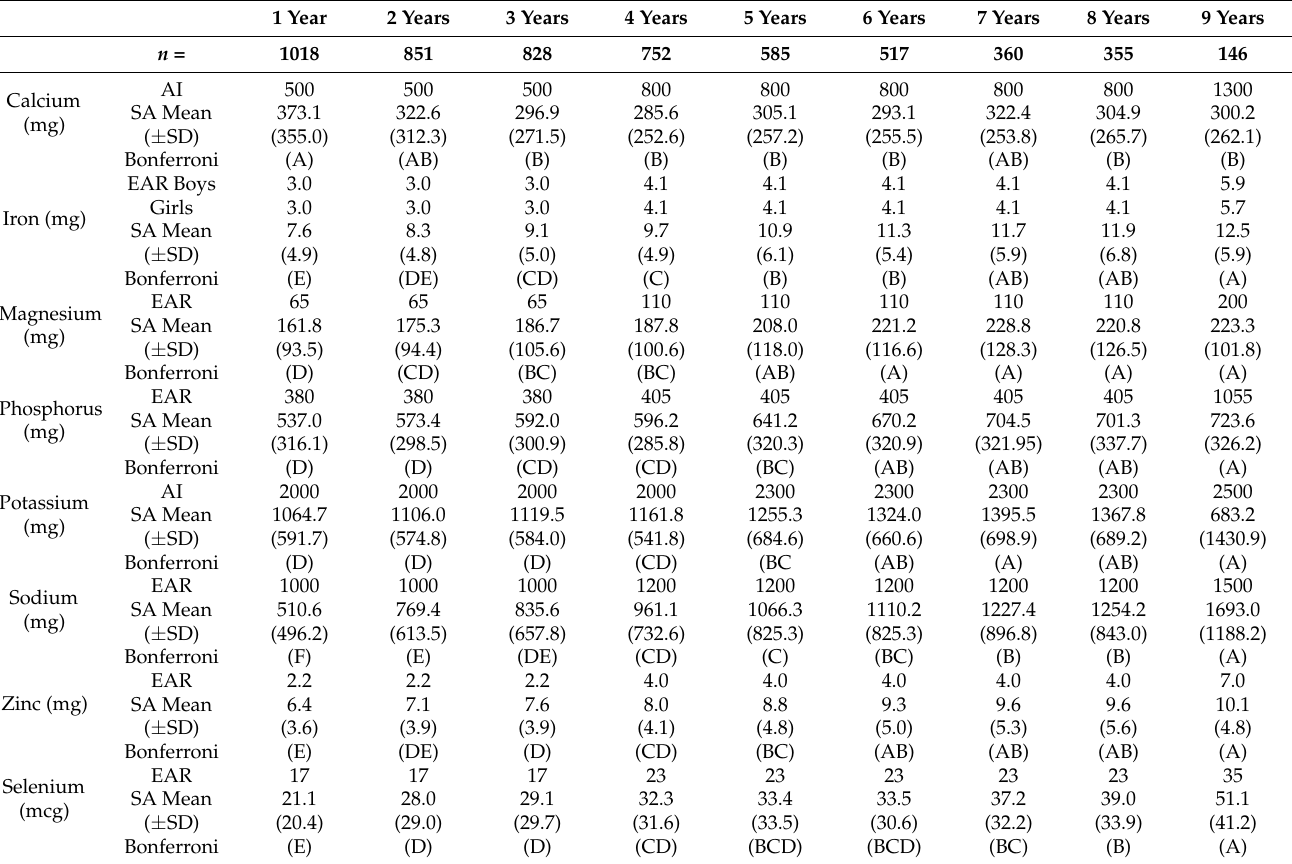
Table 4. South African child mean ± SD intake of minerals and electrolytes by year of age.